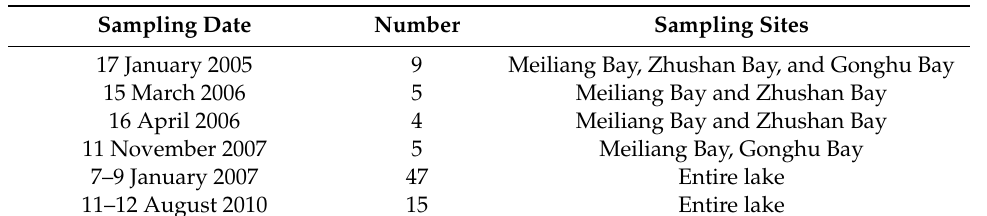
Table 2. Sampling date, number of samples, and distribution of concurrent sampling sites with MERIS for six cruises in the SAT dataset.